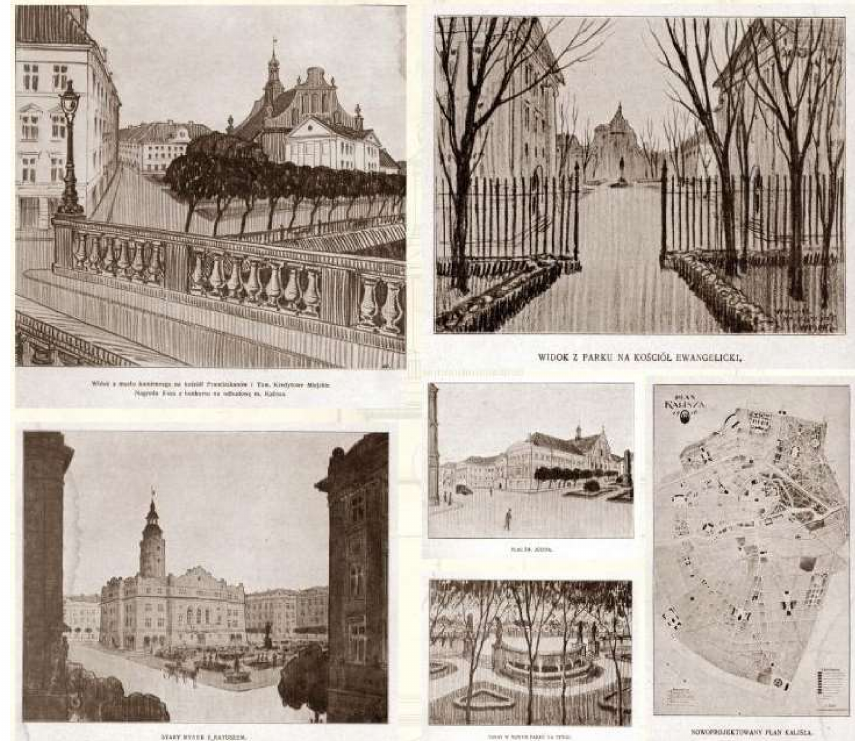
Figure 1. Drawings of the winning Kalisz reconstruction project by Tadeusz Zieli´nski, Zygmunt W ó jcicki, and Maksymilian Bystydzie´nski; 1915 Competition [16]. Reproduced with permission from Archiwum Pa´nstwowe w Kaliszu.